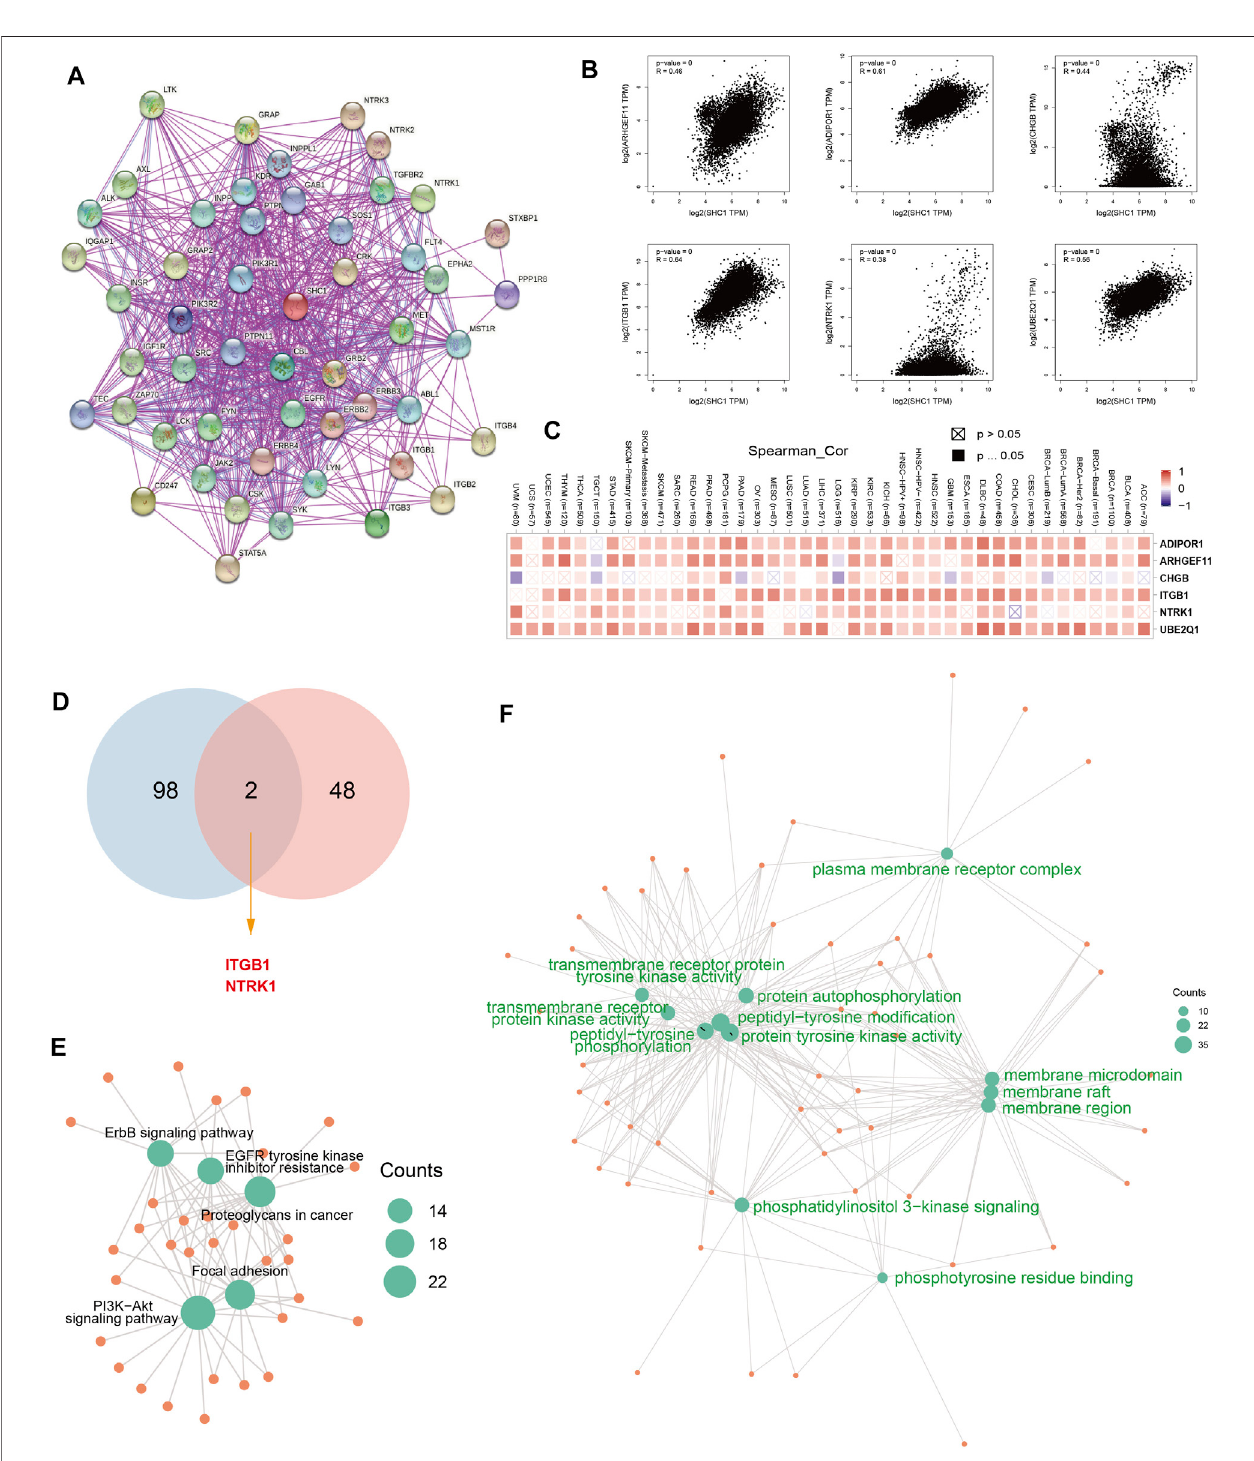
FIGURE 11 | SHC1-related gene enrichment analysis. (A) The experimentally determined SHC1-binding proteins was obtained using the web tool STRING. (B) Thetop100SHC1SimilarGenes,werealsogainedusingtheGEPIA2approachandtheexpressioncorrelationbetweenSHC1andthetop fi veselectedtargetinggenes, including ADIPOR1, ARHGEF11, CHGB, ITGB1and NTRK1 were analyzed. (C) The heatmap displayed the correlation between SHC1 expression and the expression pro fi les of fi ve selected targeting genes across the analyzed cancer types. (D) Venn diagram was conducted to display the intersection of the SHC1-binding and correlated genes. Based on the SHC1-binding and interacted genes, KEGG pathway analysis (E) and GO analysis (F) was performed. CC, cellular component; BP, biological process; MF, molecular function.